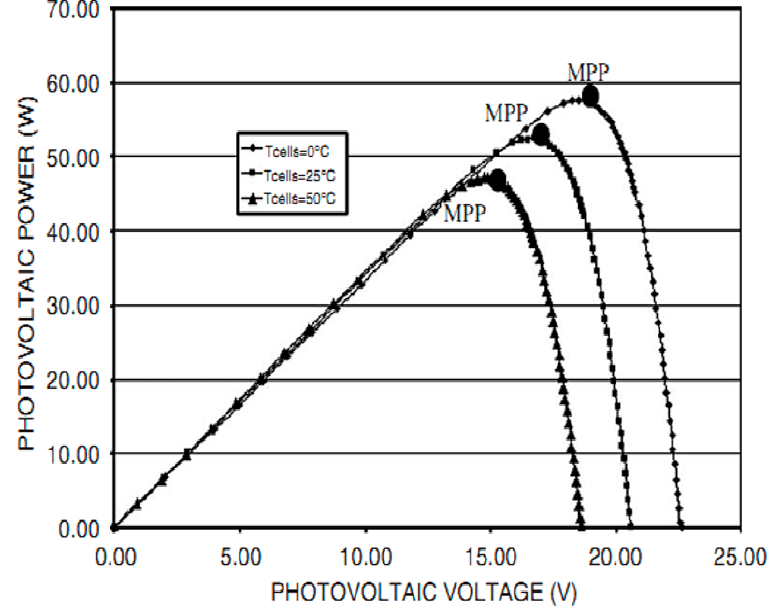
Figure 5. Characteristic curves at different temperatures.